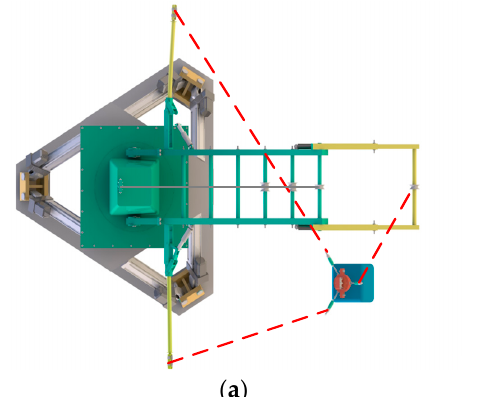
Figure 3. Simplified diagram of the marine crane with TTAS.